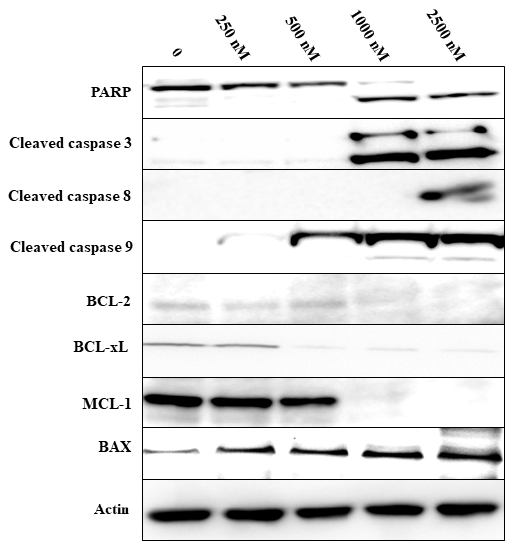
Figure 2. Cytotoxicity (MTT) of DLBCL cell lines of the GCB and ABC types incubated with KAN0441571C and venetoclax respectively for 48 h. EC 50 values for the respective drug are indicated as well as significant levels comparing KAN0441571C and venetoclax. All cell lines express phosphorylated ROR1 with the exception for U2932. For each concentration, six replicates were used and each experiment was carried out twice. NS: Not significant.